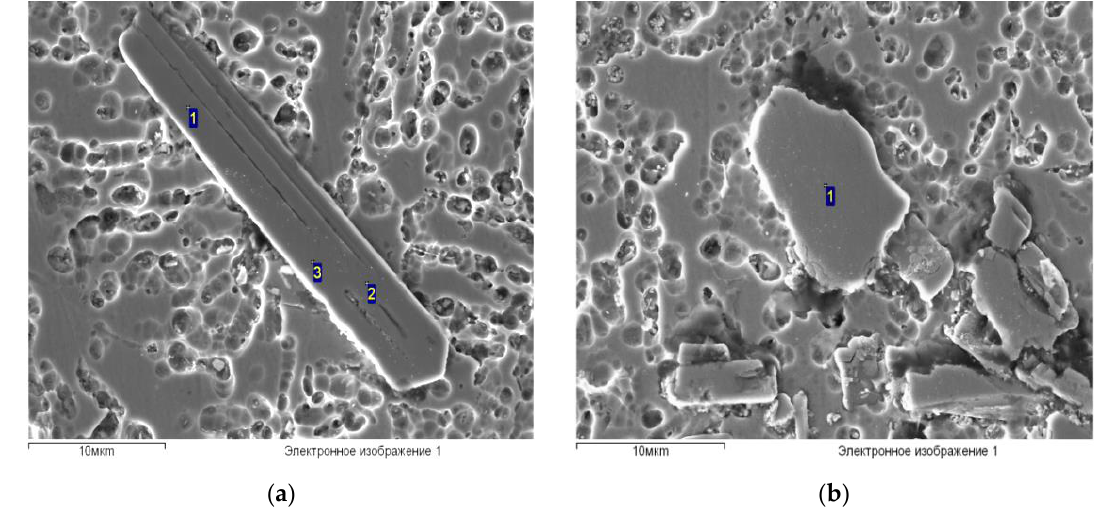
Figure 20. TiB particles in the deformed titanium matrix of the Ti-TiB alloy of a (Ti-TiB)–T110 welded joint: ( a ) boride plate retained integrity while deforming (TiB n : n = 1.47 (1); 1.01 (2); 1.16 (3)); ( b ) defragmented boride plate ( n = 1.06).